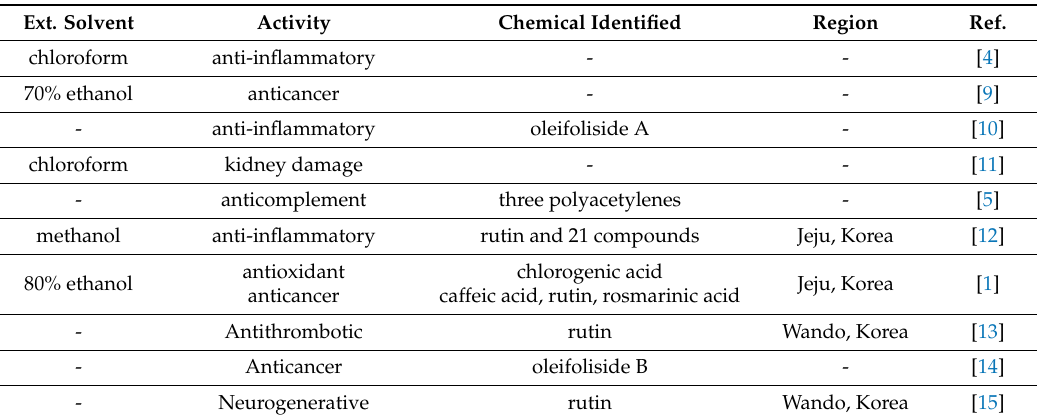
Table 1. Pharmacological activities and/or chemical constituents of D. morbifera leaf extracts reported in previous